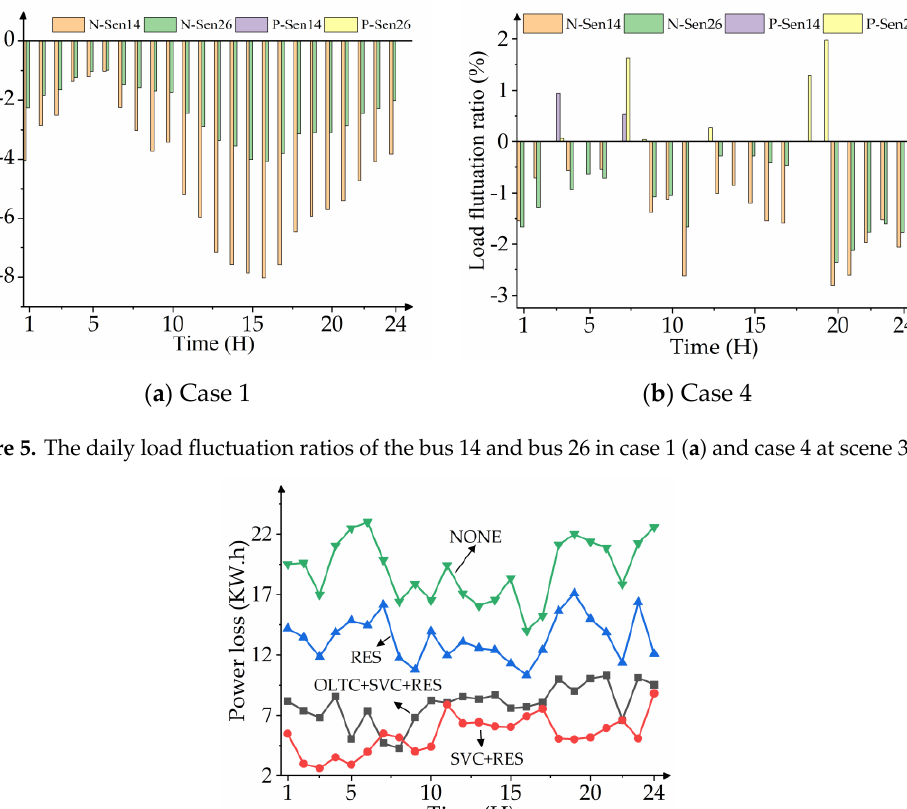
Figure 6. The daily power loss of the ADN in these four cases. Table 1. Operational cost of the four